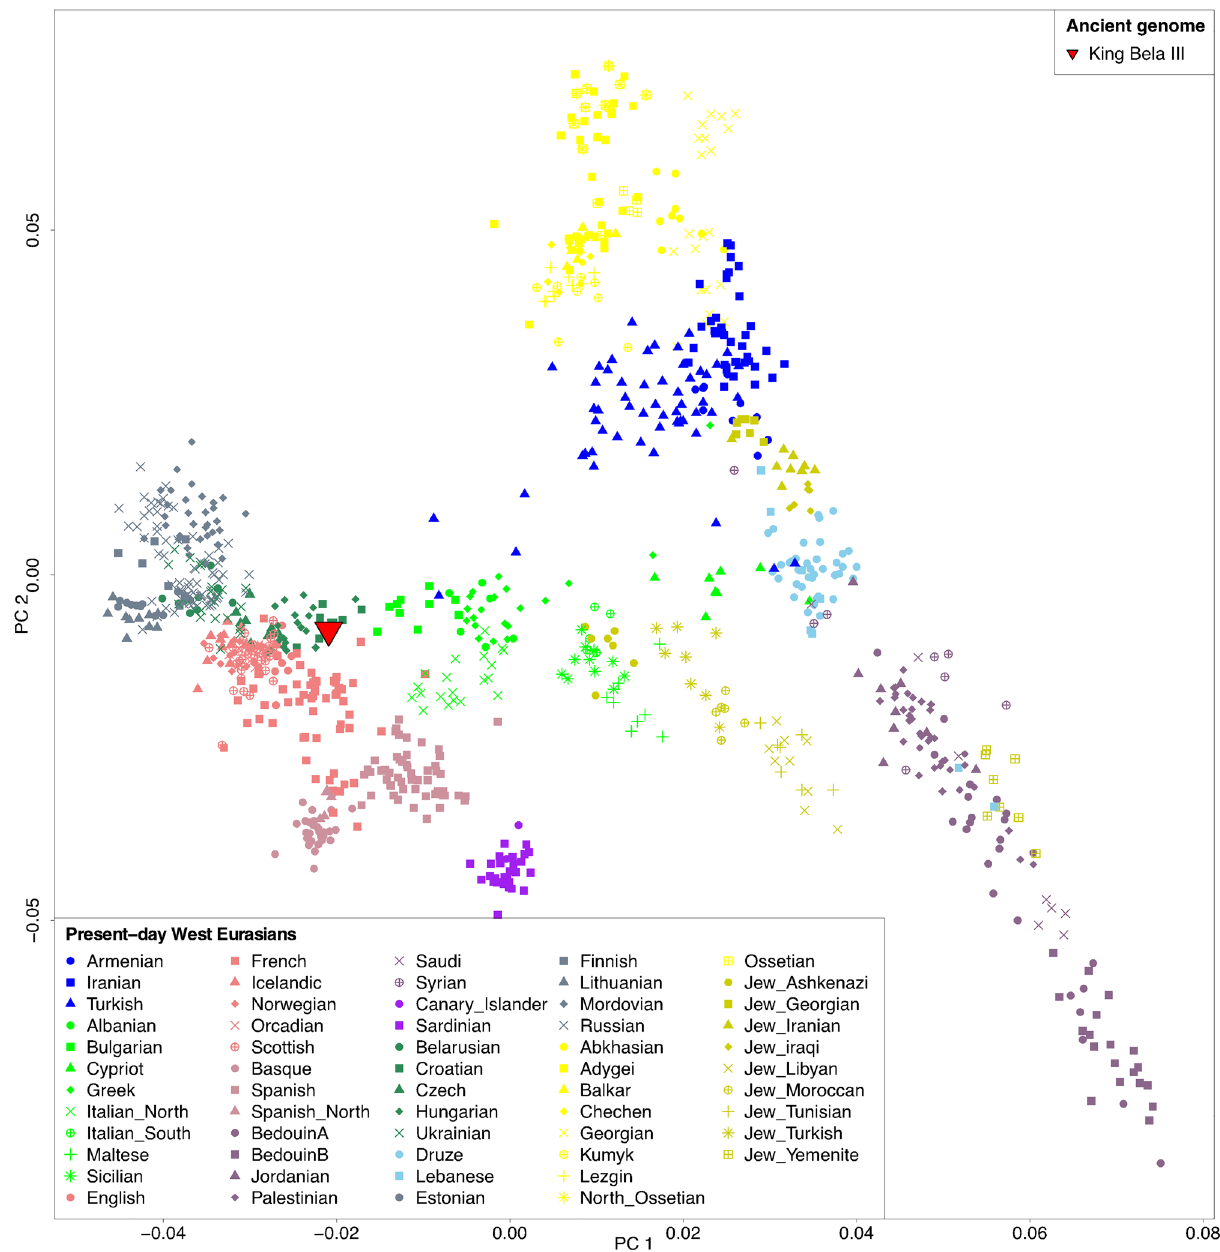
Figure 1. Principal component analysis of present-day west-Eurasians with the genome of Bela III